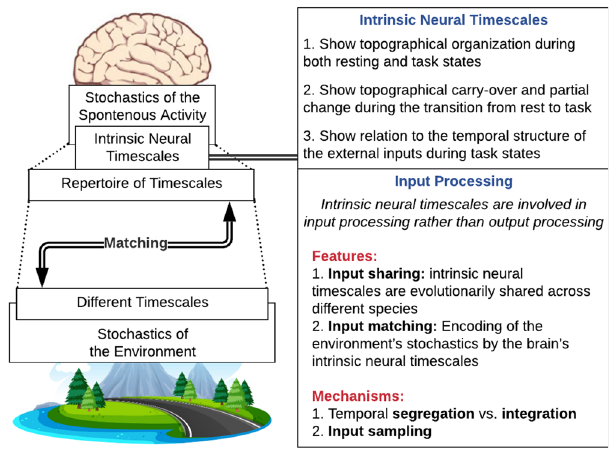
Fig. 1 The proposed function of the intrinsic neural timescales in input processing. The key assumption is that the intrinsic neural timescales process the input by matching the stochastics of neural activity with the stochastics of the environment. The nature clip art credit: Nature Vectors by Vecteez (https://www.vecteezy.com/free-vector/nature).